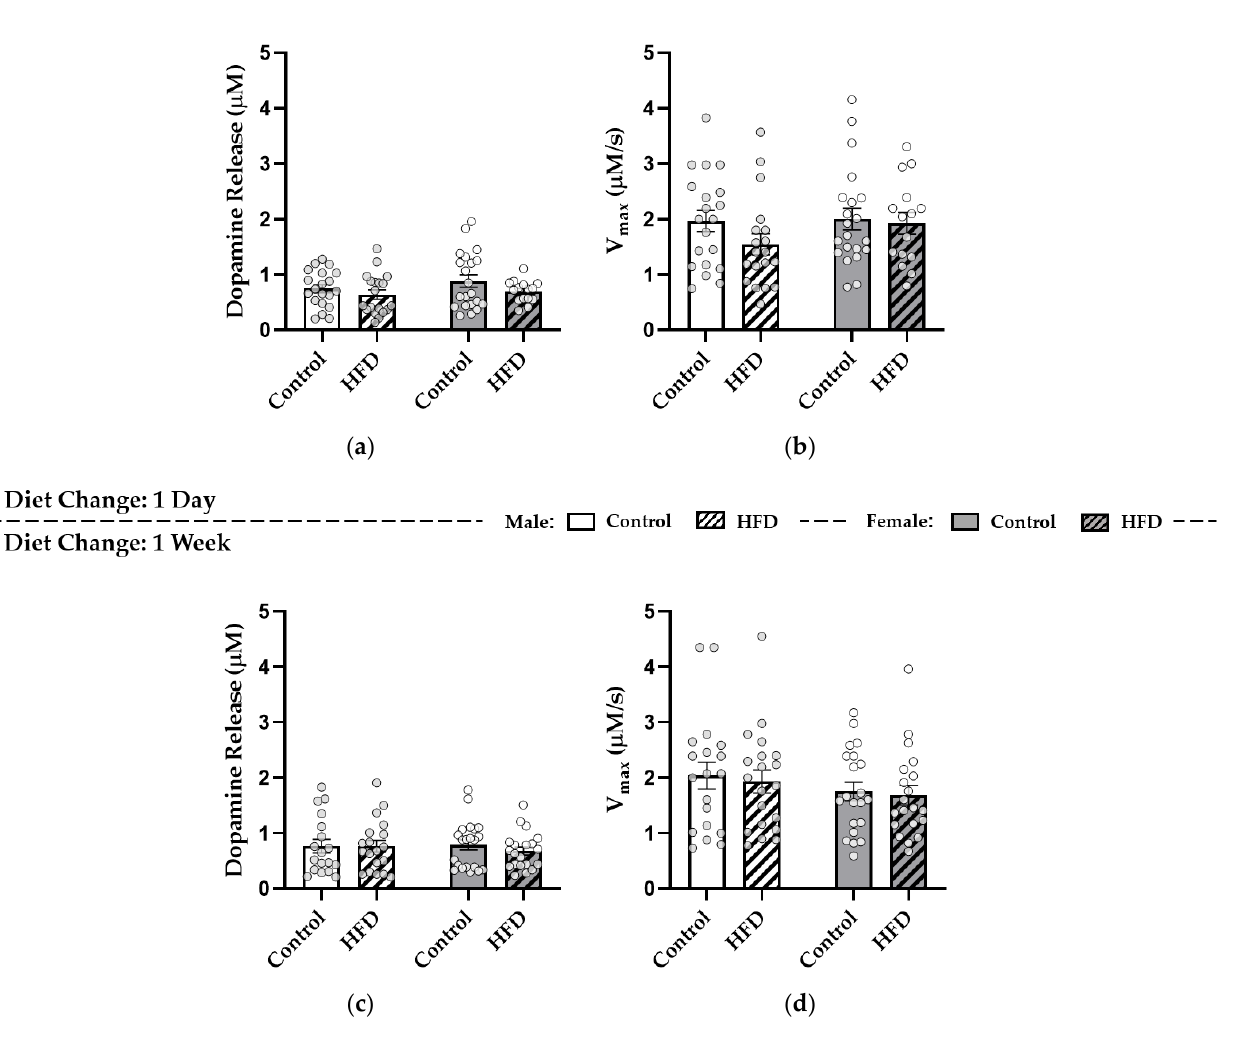
Figure 4. Effect of HFD Replacement on Baseline Dopamine Release and Reuptake within the NAc Core. Dopamine release evoked by a single electrical pulse (μM) and maximal rate of reuptake (V max ) (μM/s) after one day ( a , b ) or one week ( c , d ) of HFD replacement. No significant effects were reported.